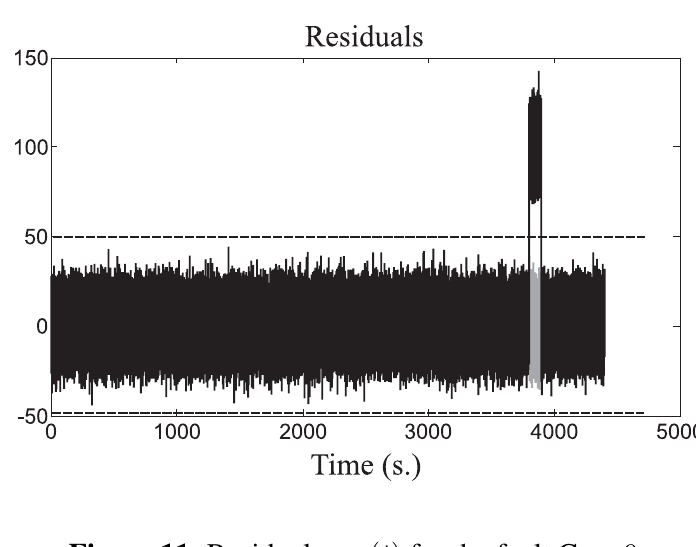
( t ) for the fault Case 8 . I i